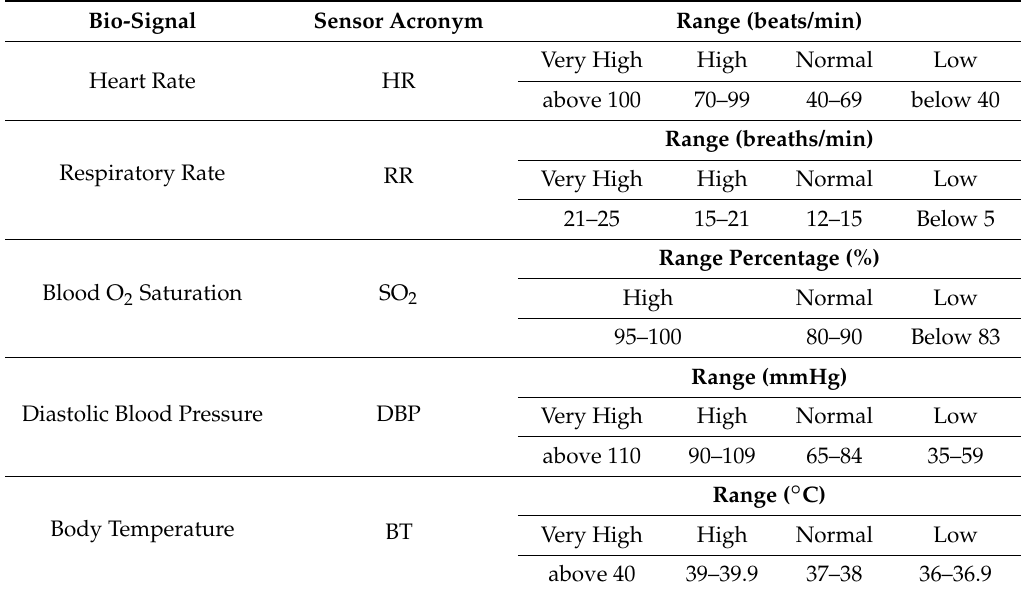
Table 1. The five vital signs and their sensor acronyms used in this